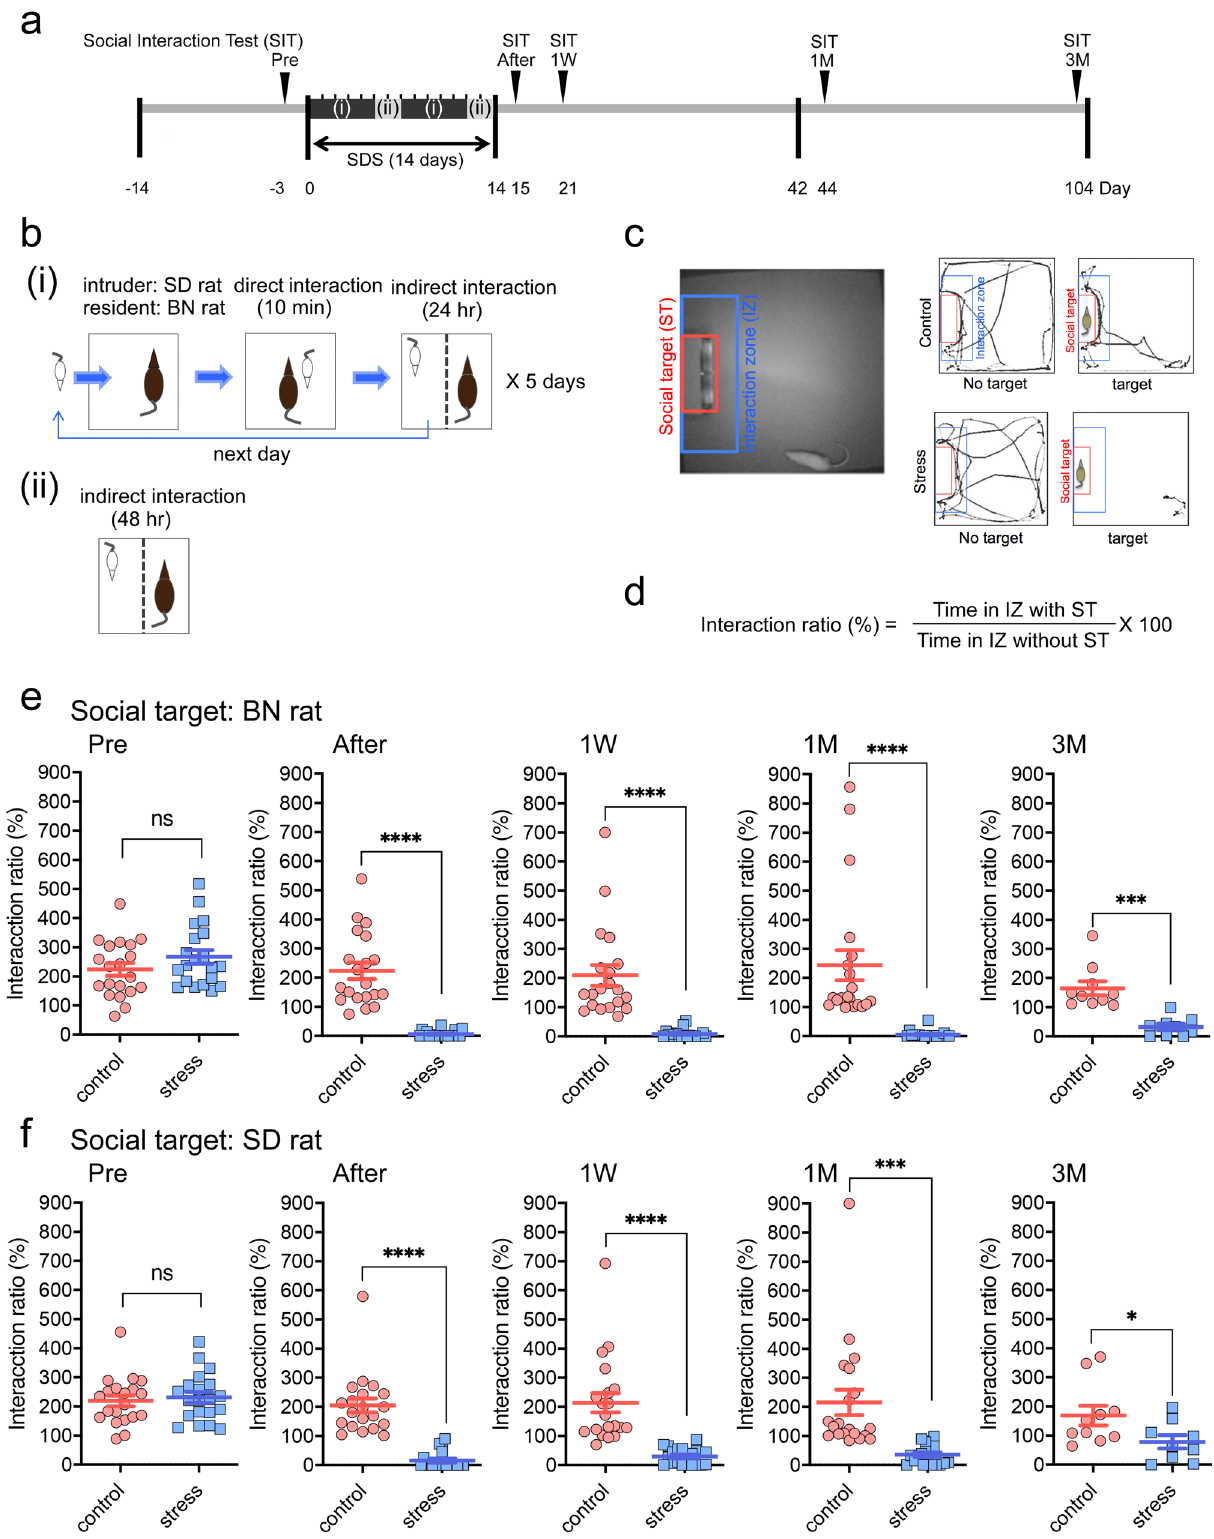
Figure 1. Novel social defeat stress (SDS) rat model. ( a ) Experimental schedules for SDS and the social interaction test (SIT). The 14-day SDS paradigm consisted of two processes ((i) and (ii)). ( b ) The SDS procedure applied to this model: a 10-min direct interaction followed by a 24-h indirect interaction was conducted once per day for five days (i). A 48-h indirect interaction was applied for two days without any direct interaction (ii). This combination was repeated twice during a 14-day SDS period. ( c ) SIT for rats. The interaction zone (IZ) is defined by the blue rectangle. ( d ) Calculation of the interaction ratio. ( e, f ) SIT with BN ( e ) and SD ( f ) rats before (Pre) SDS and at 1 day (After), 1 week (1 W), 1 month (1 M), and 3 months (3 M) after the 14-day SDS. * p < 0.05, *** p < 0.0005, **** p < 0.0001, two-tailed, unpaired t